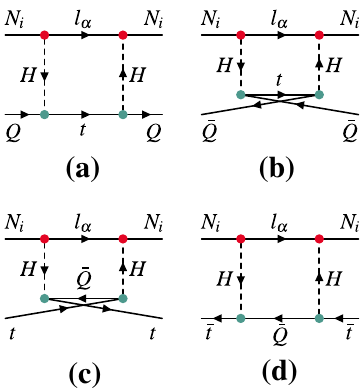
Fig. 3 Forward diagrams for the O ( Y 2 Y 2 t ) corrections to the N i → lH decayrateandthecorresponding neutrinoquarkscatterings.Similar diagrams, with all arrows reversed, contribute to N i → ¯ l ¯